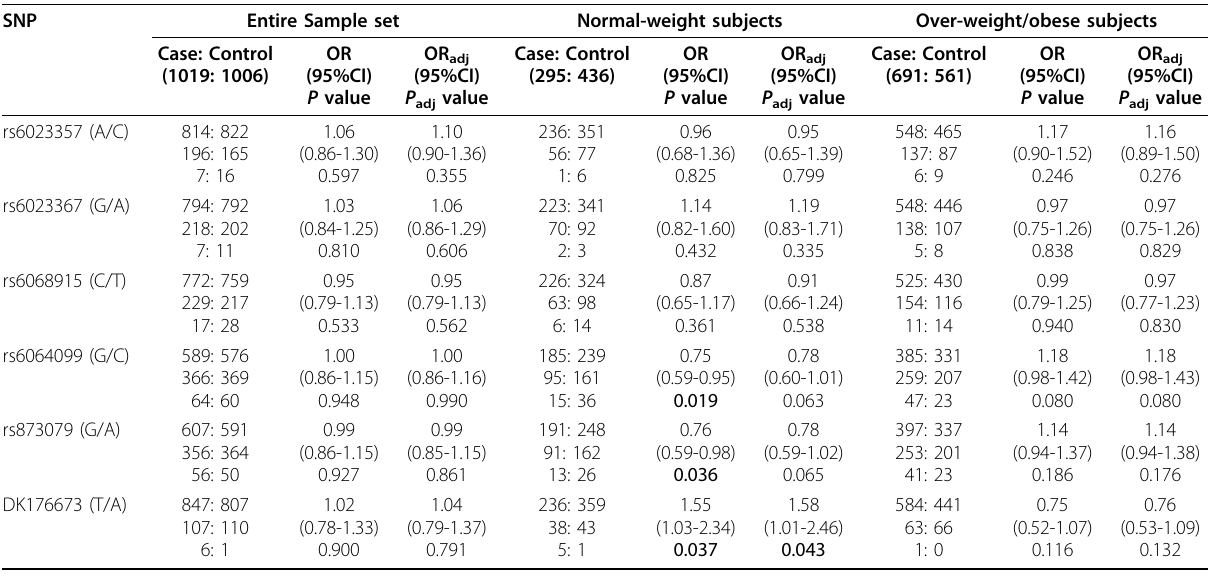
Table 2 Association of DOK5 SNPs with type 2 diabetes in North Indian population Entire Sample set Normal-weight